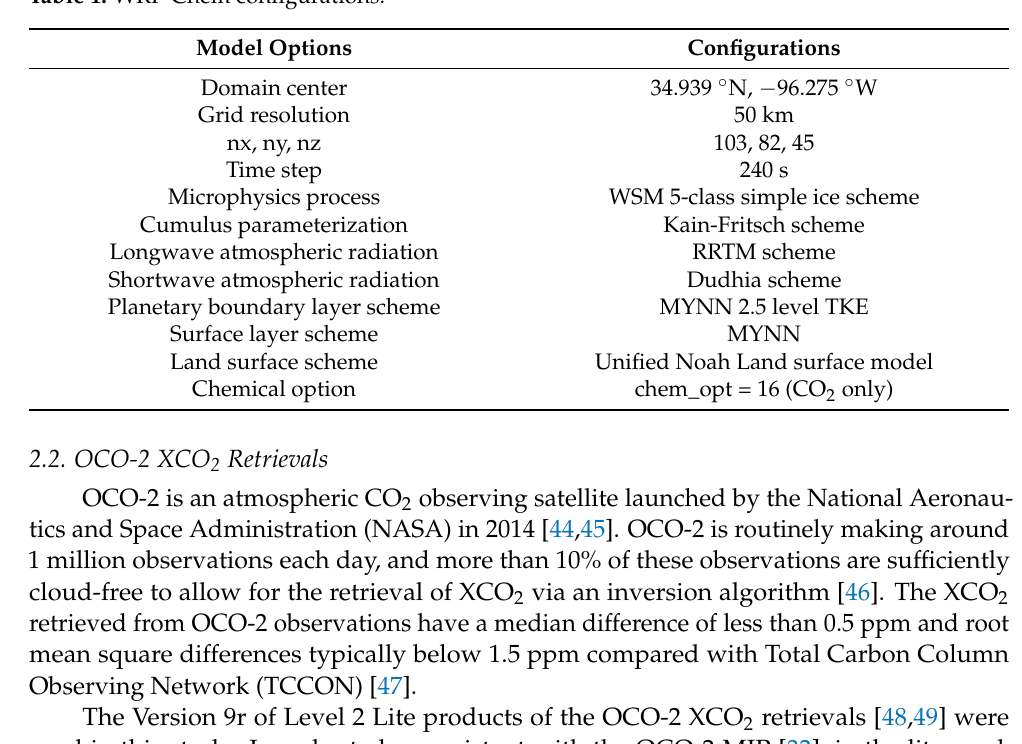
Table 1. WRF-Chem